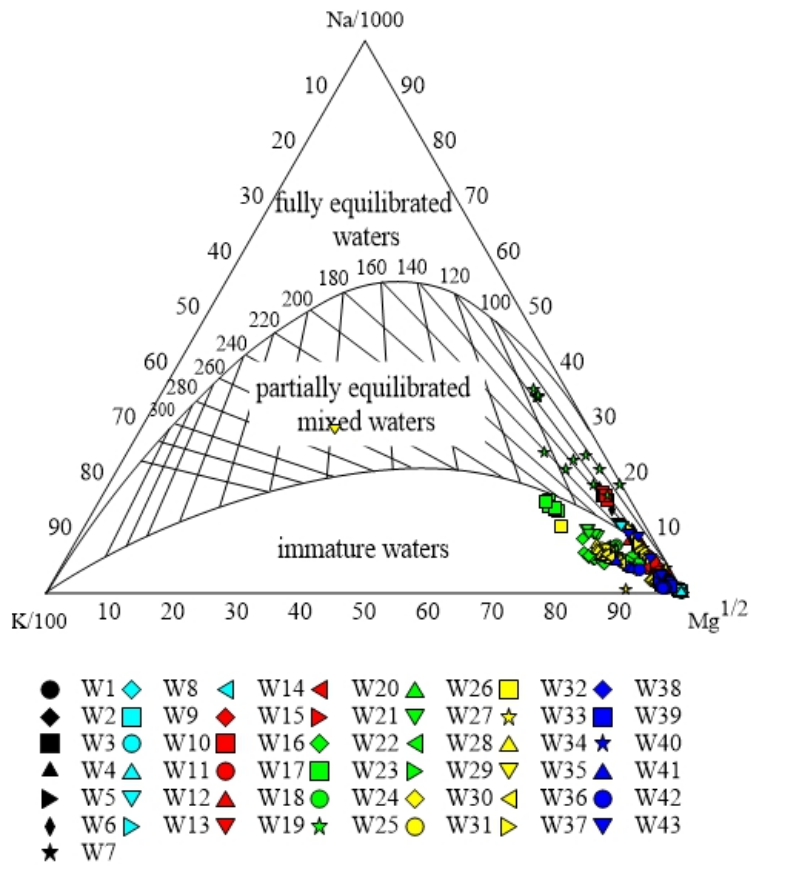
Figure 6. Distribution of aqueous samples on the Na/1000-K/100-Mg 1/2 ternary diagram.